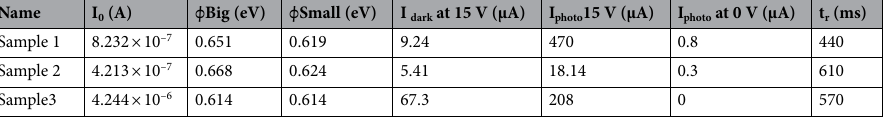
Table 1. Reverse saturation current, Schottky barrier’s height, I dark at 15 V, I photo at 0, 15 V and t r for samples.